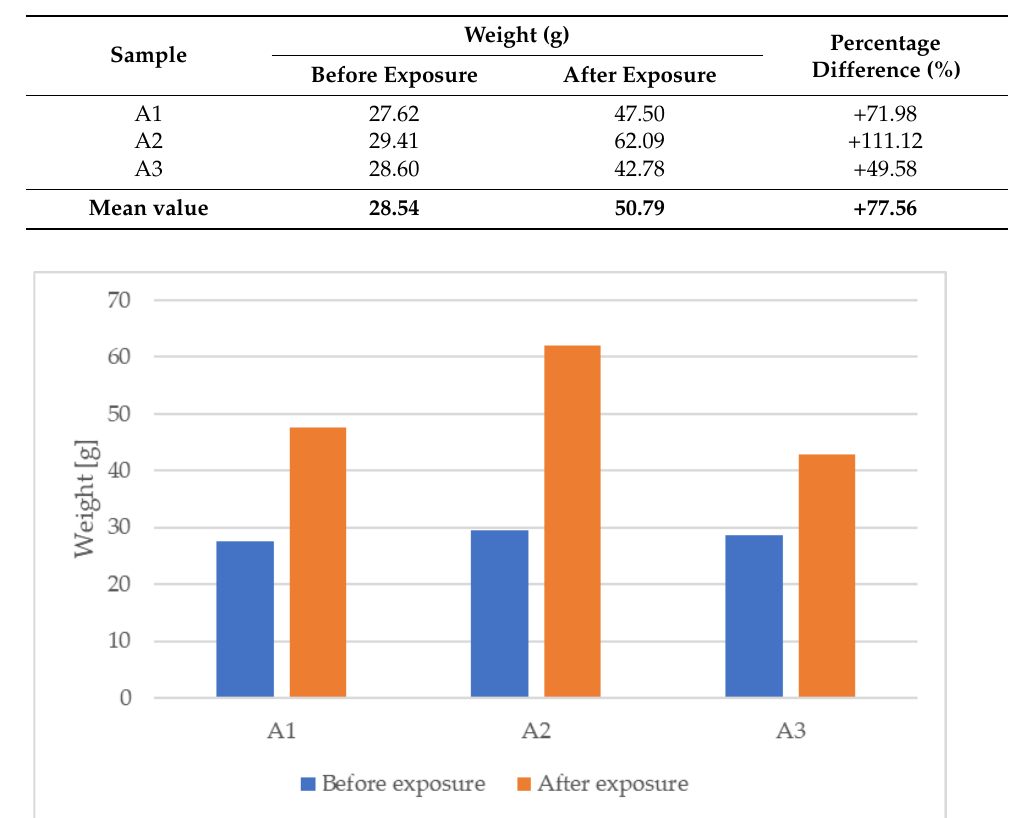
Table 5. Summary of thermal conductivity measurement values before and after environmental